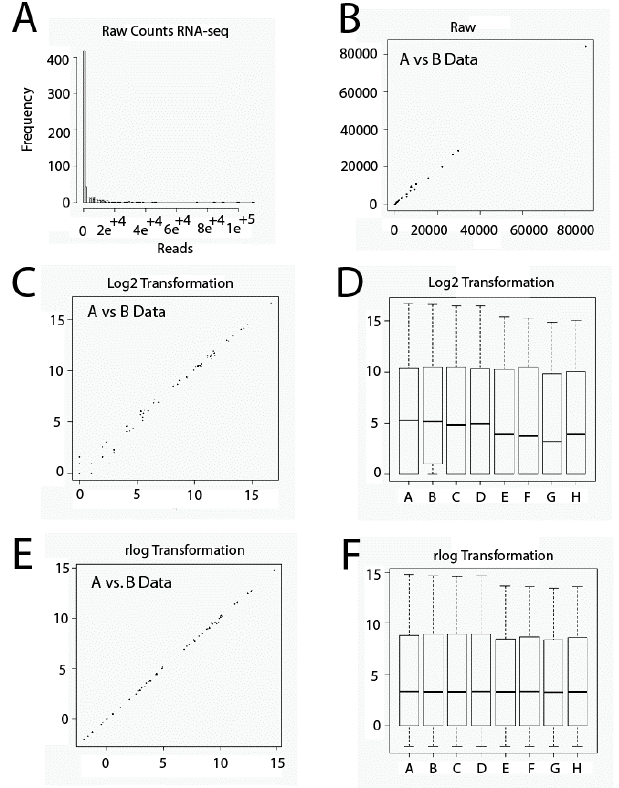
Figure 1. Gene expression level data transformation. Raw data set values ( A , B ). Log2 transformation ( C , D ); rlog transformation ( E , F ). RNA-seq: RNA-sequencing.